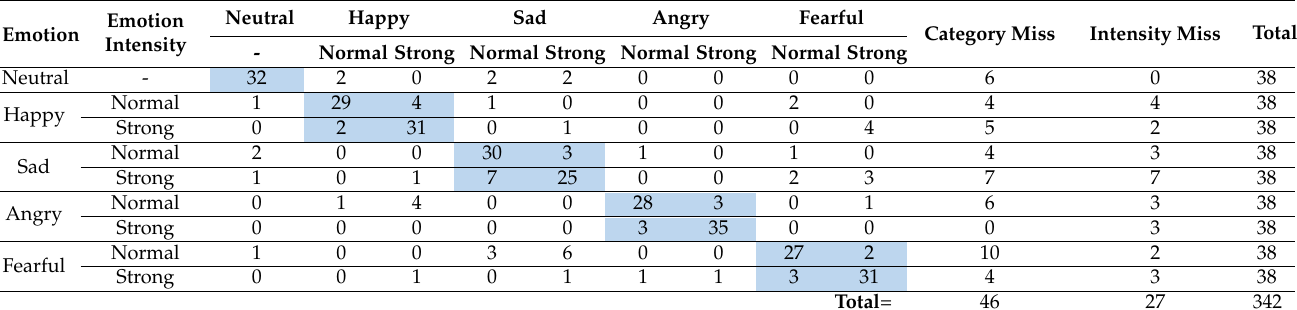
Table 2. The test set confusion matrix by Single DL framework for emotion recognition with intensity